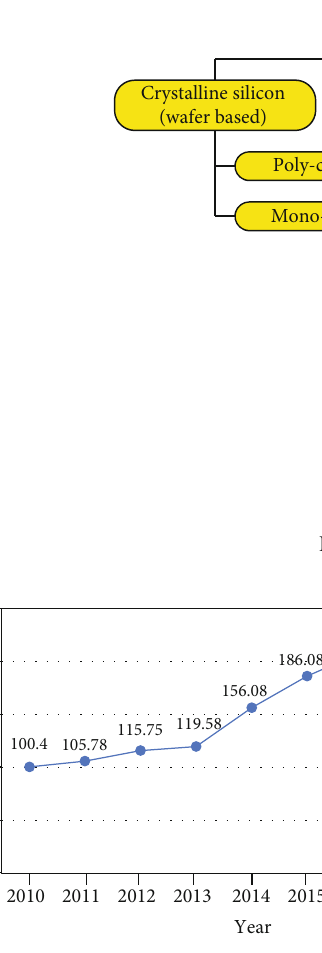
Figure 9: Assessment of installed generation capacity in MW on the national grid [43].